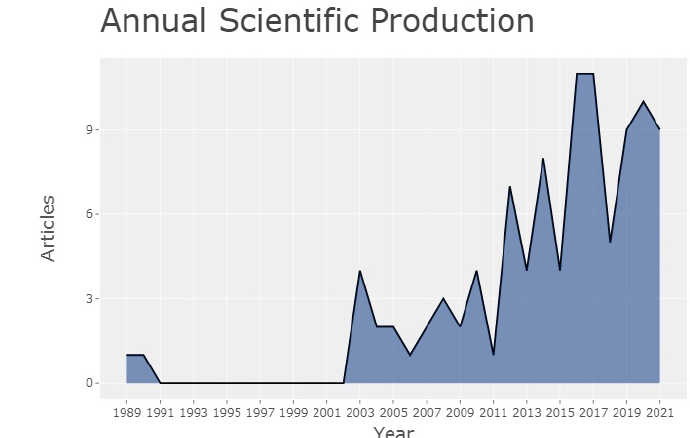
Fig. 3. Growth of papers on ISOP in Google Scholar and Scopus